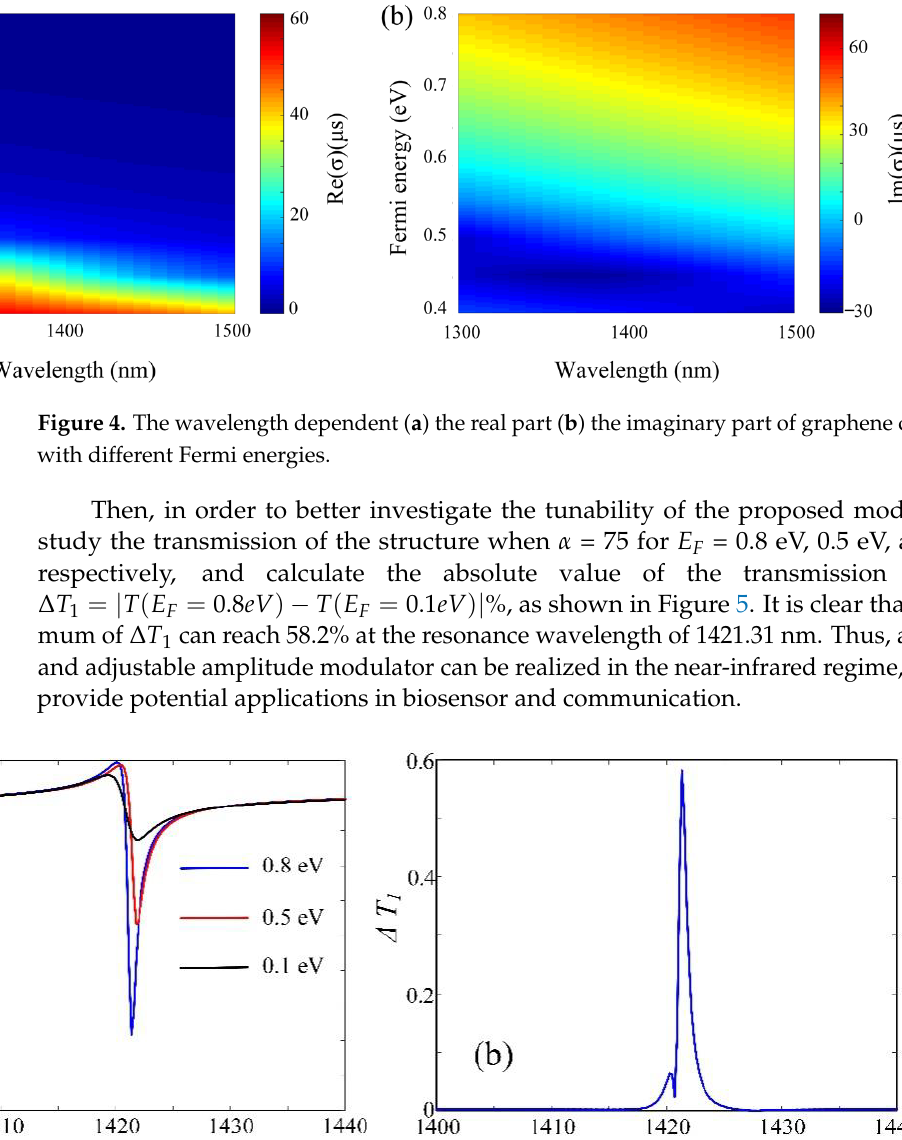
Figure 6. Comparison of the transmission without and with graphene ( E F = 0.5 eV) based on the different ( a ) α = 0, ( b ) α = 50, ( c ) α = 60, ( d ) α = 75 .